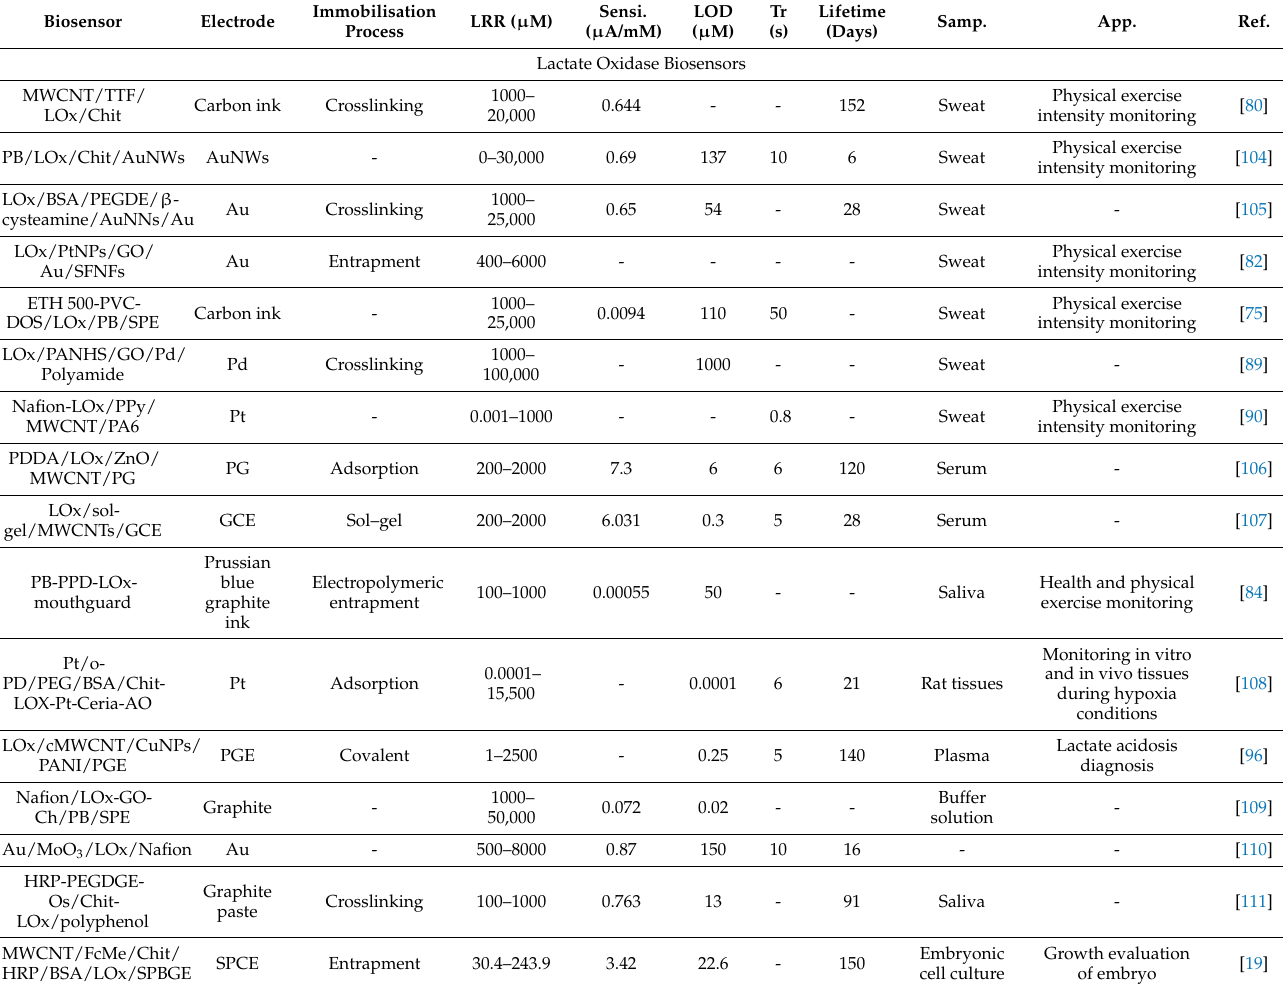
Table 2. Most relevant cases in the employment of lactate biosensors in biomedicine and